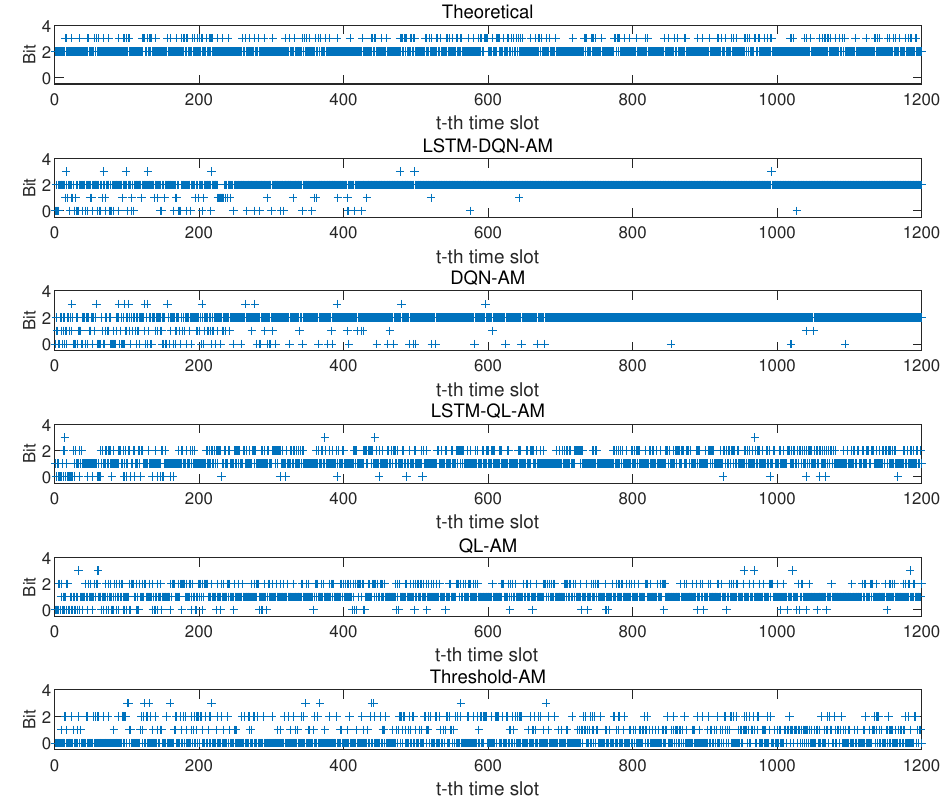
Figure 16. The received number of bits in the AM schemes in the sea